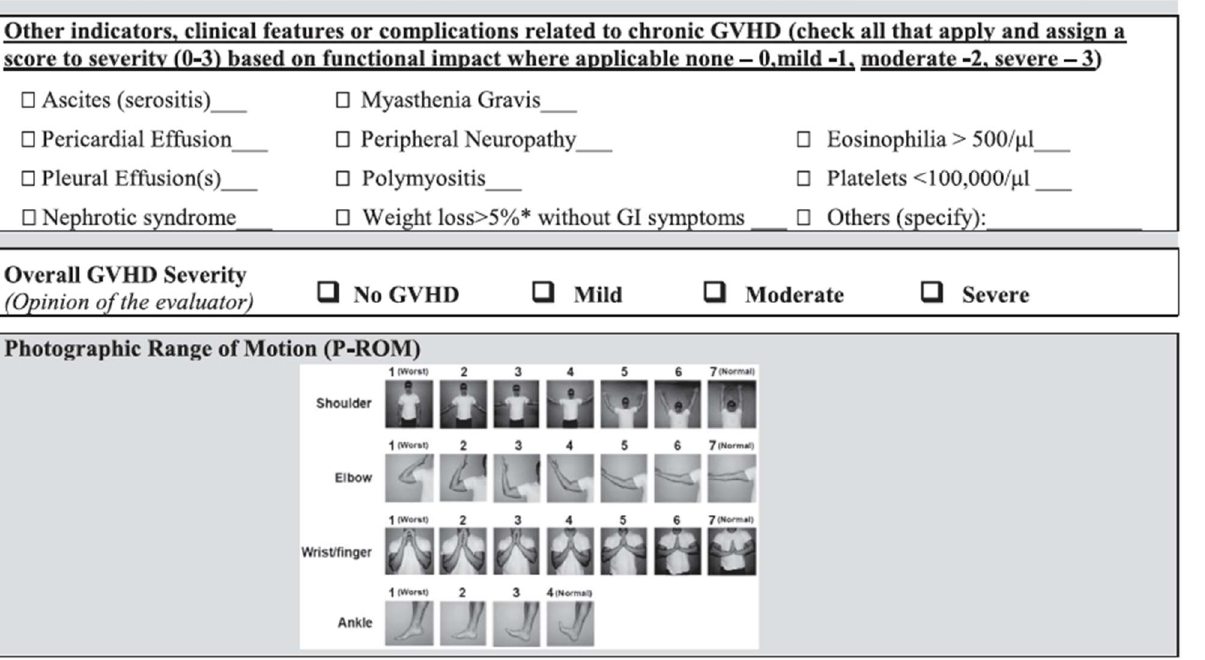
Legend . Section of organ system scoring card relevant to musculoskeletal complications of chronic GVHD as drafted by The National Institutes of Health Consensus Development Project on Criteria for Clinical Trials in Chronic Graft-versus-Host Disease in 2014. The scoring card focuses mostly on musculoskeletal changes related to joint contractures, fasciitis and their related manifestations with a photographic range of motion scale provided for ranking perceived joint range of motion. There is also a box that can be ticked with a related severity scale of 1-3 in case of noted polymyositis.